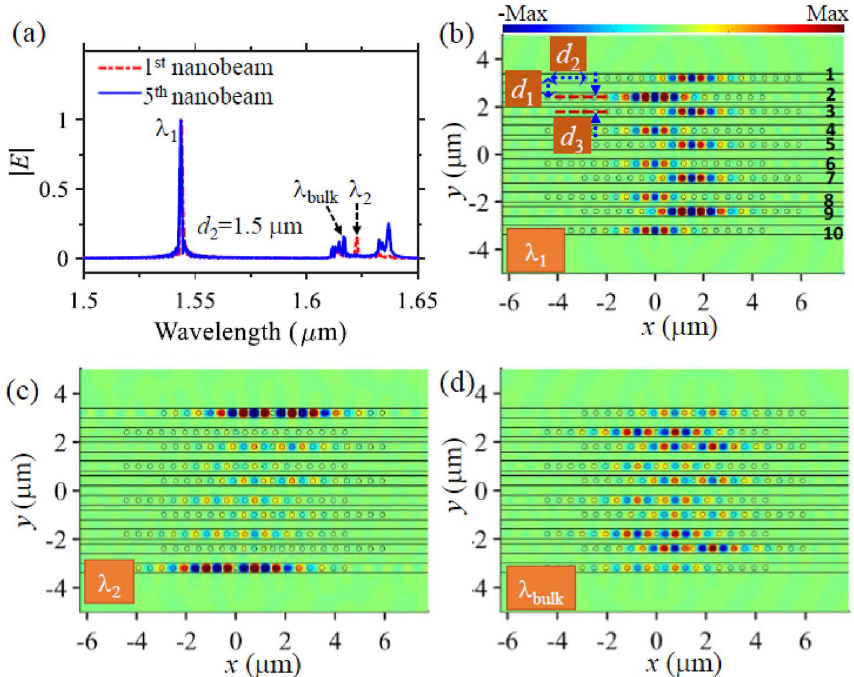
Figure 4. Optical properties of the TESs enabled by SSH configuration with axial shift of d 2 = 1.5 µ m between the adjacent nanobeams. ( a ) The spectra of the first and the fifth nanobeams of the SSH structure, showing a merged peak at wavelength (cid:31) 1 = 1.546 µ m and suggesting the edge mode not being allowed at (cid:31) 1 due to weak coupling strength at this wavelength. ( b – d ) The real part of the field distribution H z of the SSH structure in the middle plane of the nanobeam membrane at (cid:31) 1 = 1.546 µ m , (cid:31) 2 = 1.624 µ m , (cid:31) bulk = 1.617 µ m , respectively. The geometrical parameters of the SHH structures are the same as those in Fig. 2 except a 1.5 µ m axial shift between the neighboring